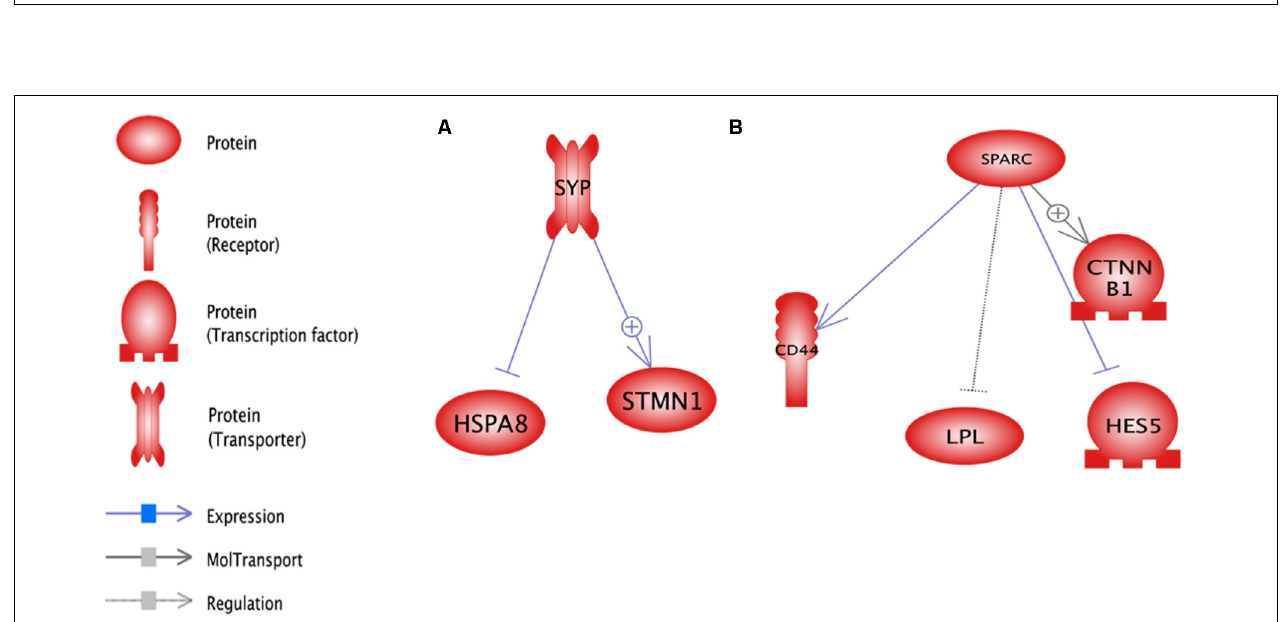
FIGURE 7 | Common regulation analysis between DEGs in lactation process. The green and blue boxes are up- and down-regulated genes, respectively. CTNNB1 , CD44 and LPL genes have the most common regulation.